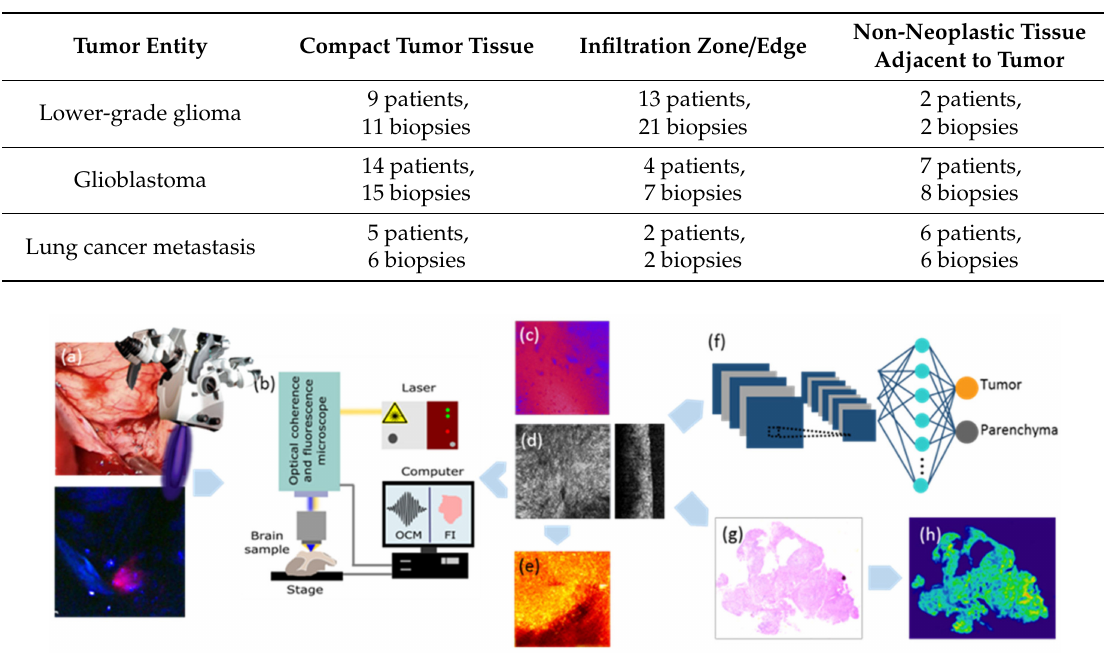
Table 1. Patient and biopsy cohort with respect to tumor entity (LGG, GB, MET) and histology-derived tissue type (TU, INF / EDGE, BP).